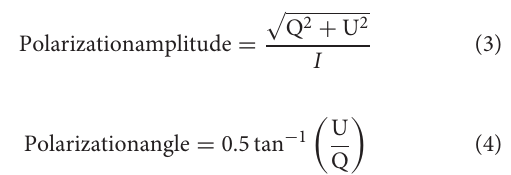
a set of field inclinations outside this inclination